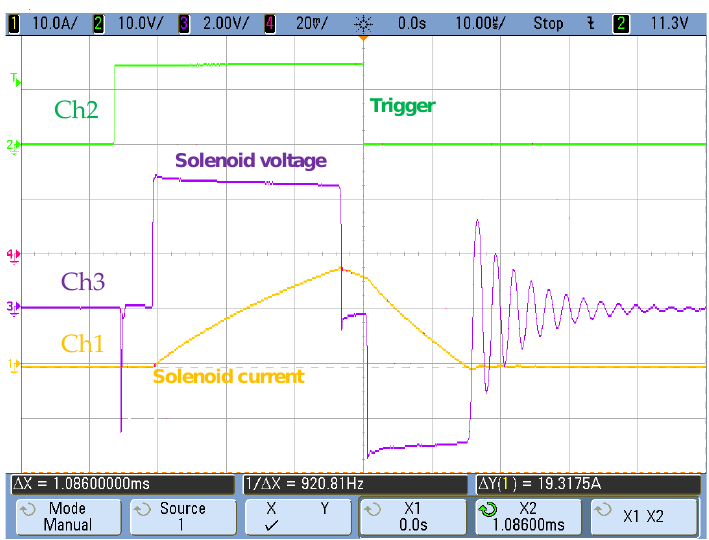
Figure 10. Waveforms at the solenoid. Ch1 represents solenoid current, Ch3 solenoid voltage, and Ch2 the trigger signal.